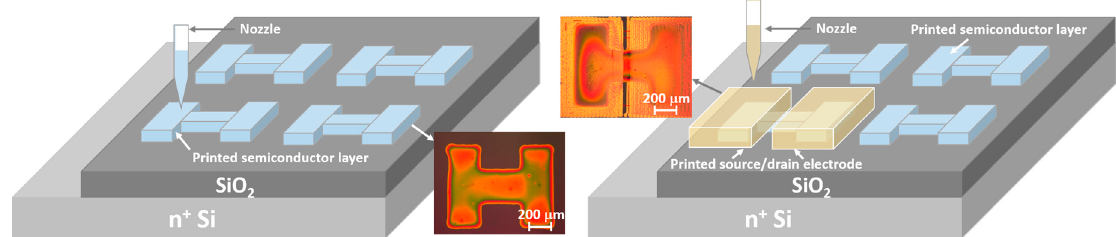
Figure 1. Schematic diagram of the procedures for fabricating a printed InGaZnO TFT. The nozzle was filled with the InGaZnO solution, forming a patterned layer with a thickness of 30 to 120 nm. Then, after annealing, the nozzle containing the solution of silver nanoparticles formed the 60 to 80 nm source and drain electrodes on the semiconductor layers.